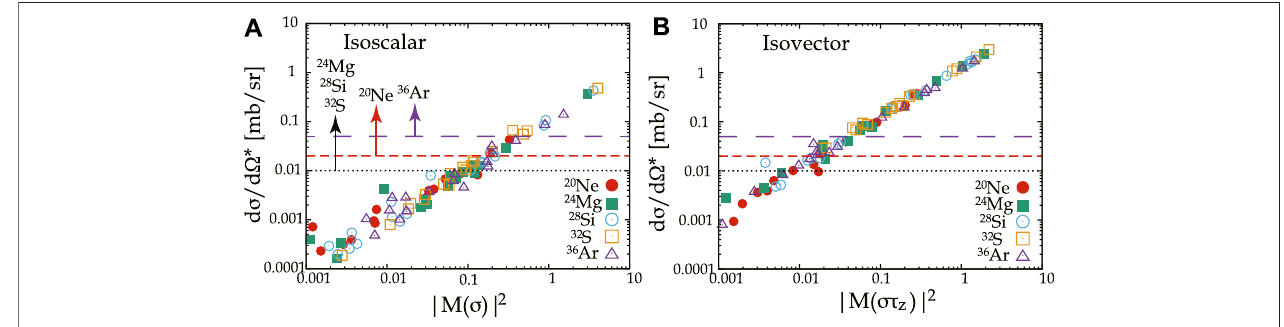
FIGURE 5 | Proportionality of UCS. Horizontal lines indicate experimental detection limit for 24 Mg, 28 Si and 32 S (dotted), 20 Ne (short-dashed) and 36 Ar (long- dashed). Cross-section is corrected in terms of mass dependence as in Eq. 34 .